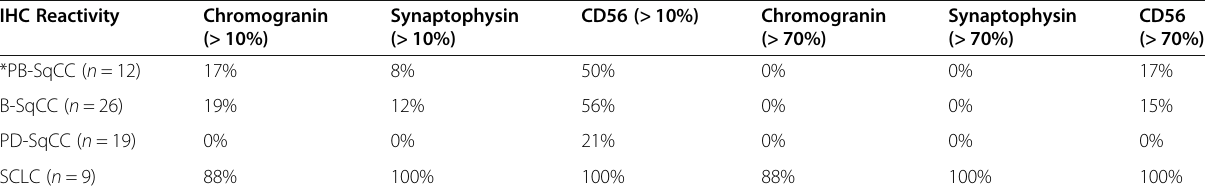
Table 2 IHC marker reactivity by tumor type IHC